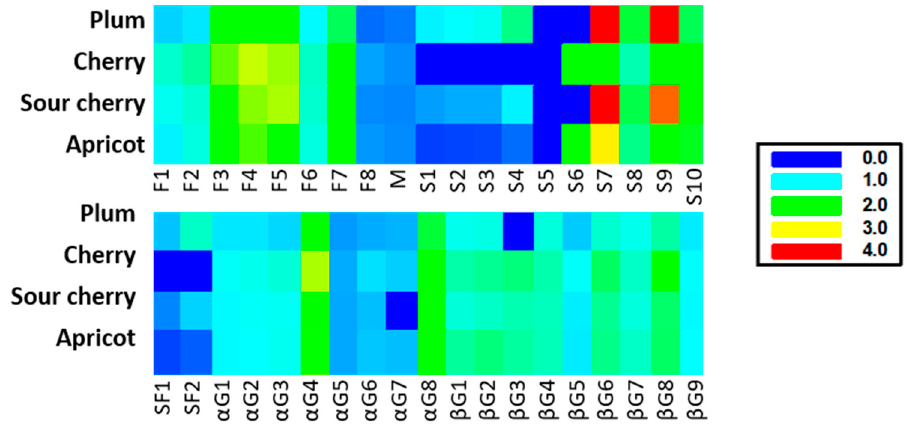
Figure 2. Heat map built on 1 H-NMR carbohydrates signals (F1–F8, fructose signals; M, methanol signal; S1–S10, sucrose signals; SF1 and SF2, sucrose-fructose signals; α G1– α G8, alpha glucose sig- and β G1– β G9 represent the beta glucose nals; and β G1– β G9 represent the beta glucose signals).